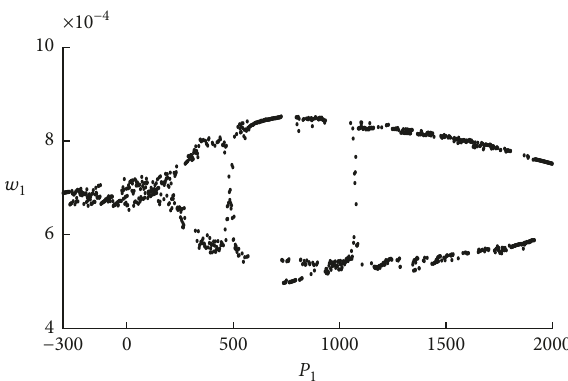
Figure 4: The bifurcation diagram of the system with change of P